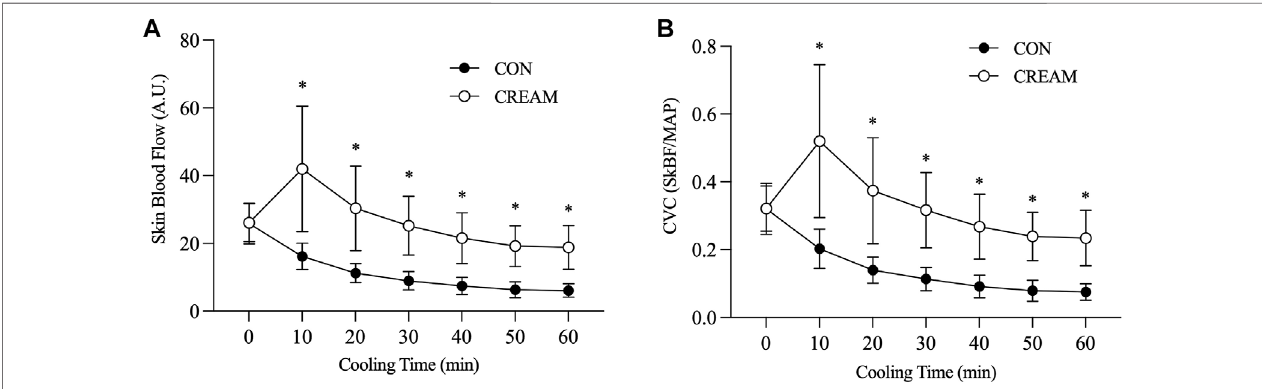
FIGURE2| Skinblood fl ow(SkBF)andcutaneousvascularconductance(CVC)duringlocalskincooling.SkBF (A) andCVC (B) duringBaseline(0 min)and60-min local cooling are shown. CON, control cooling; CREAM, cooling with cutaneous application of analgesic cream. Two-way repeated measures ANOVA with a Tukey ’ s post-hoc test for all. Data are presented as the mean ± SD ( n = 10). * p < 0.05 vs. CON.